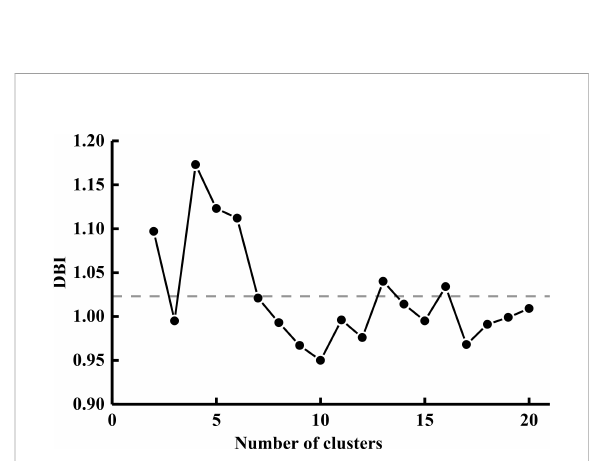
FIGURE 7 The Davies-Bouldin index evaluating clustering ef fi ciency against the number of clusters. Lower index values indicate better clustering results. The dotted line represents the mean value of the index.